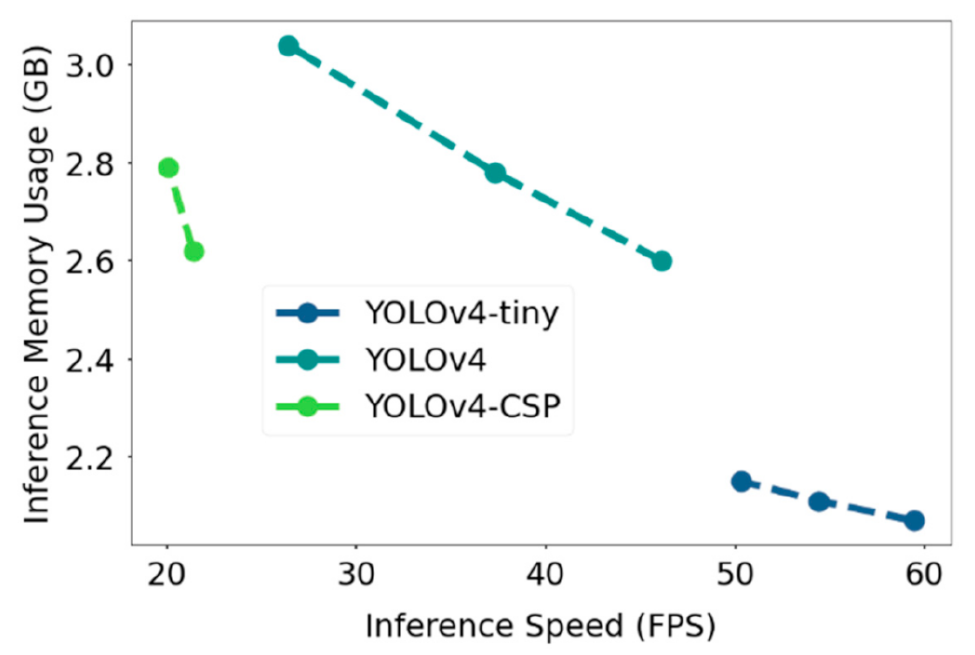
Figure 18. Comparison of YOLOv4 models in terms of speed and GPU memory usage at inference time. The specific values are in Table